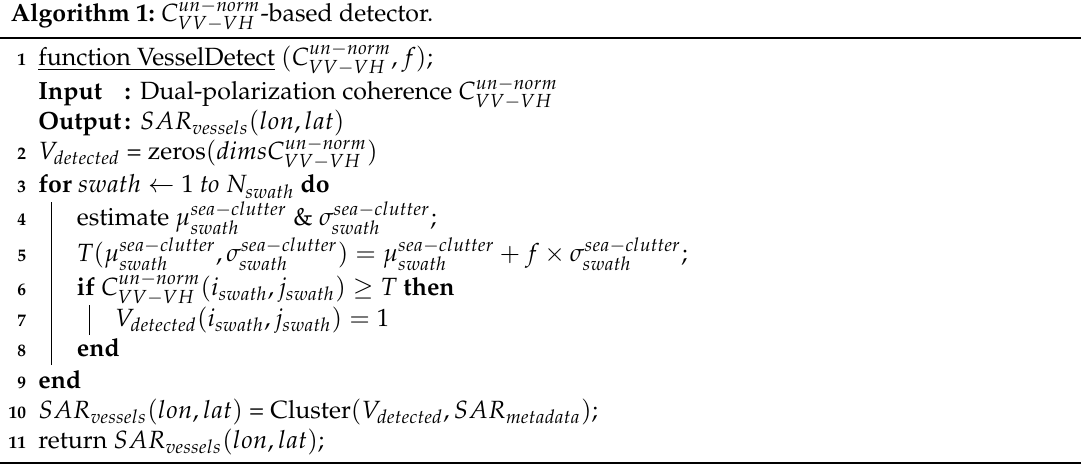
Algorithm 1: C un − norm